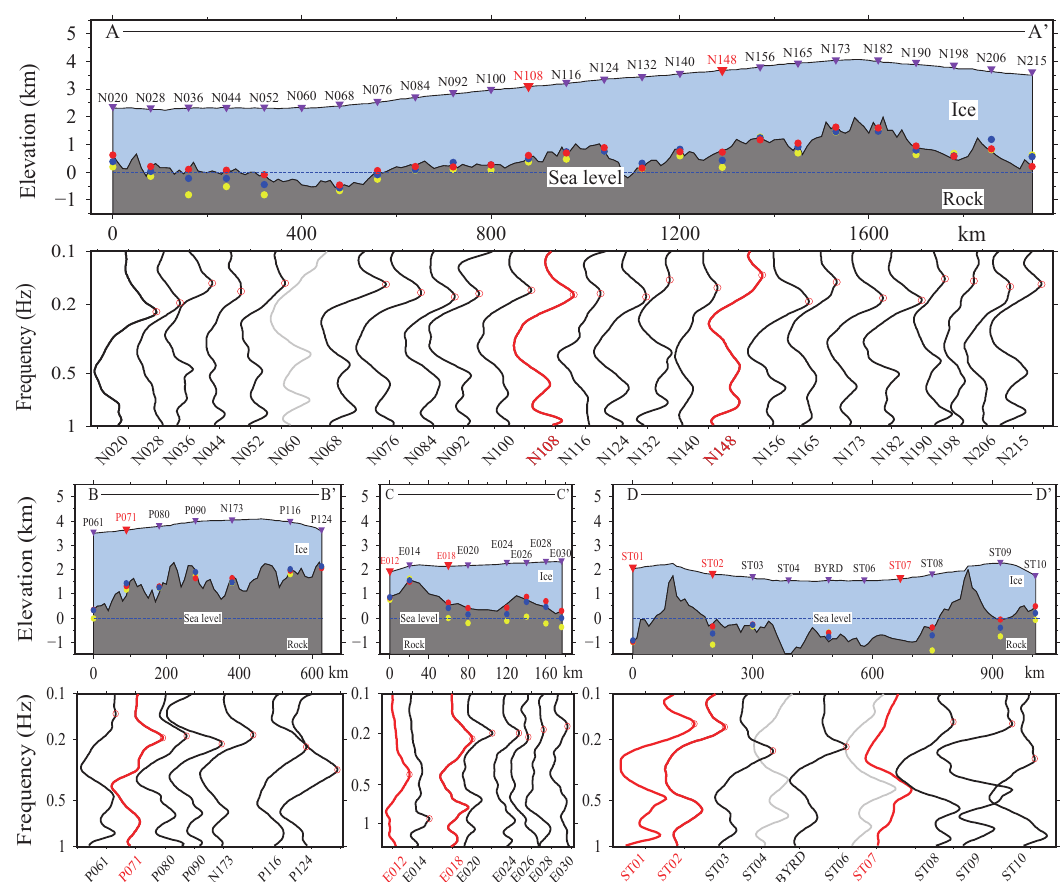
Figure 4. Cross section showing H / V spectra and the ice sheet thickness obtained from the H / V method at stations along the four profiles (Fig. 1). In the below H / V spectra cross section panels, the red circles denote the resonance frequencies correlating to the ice thickness for each station. The spectra of the four stations without clear peaks are plotted with grey lines. The spectra together with their station names that are shown in red, correspond to the stations displayed in Fig. 3. The upper panels show the variation of the bedrock and ice surface elevation along each profile obtained from Bedmap2 database. In these plots, the red dots indicate the reference Bedmap2 ice thickness, while the yellow and the blue dots represent the Eq. (1) estimates and the DFA + Model B estimates,